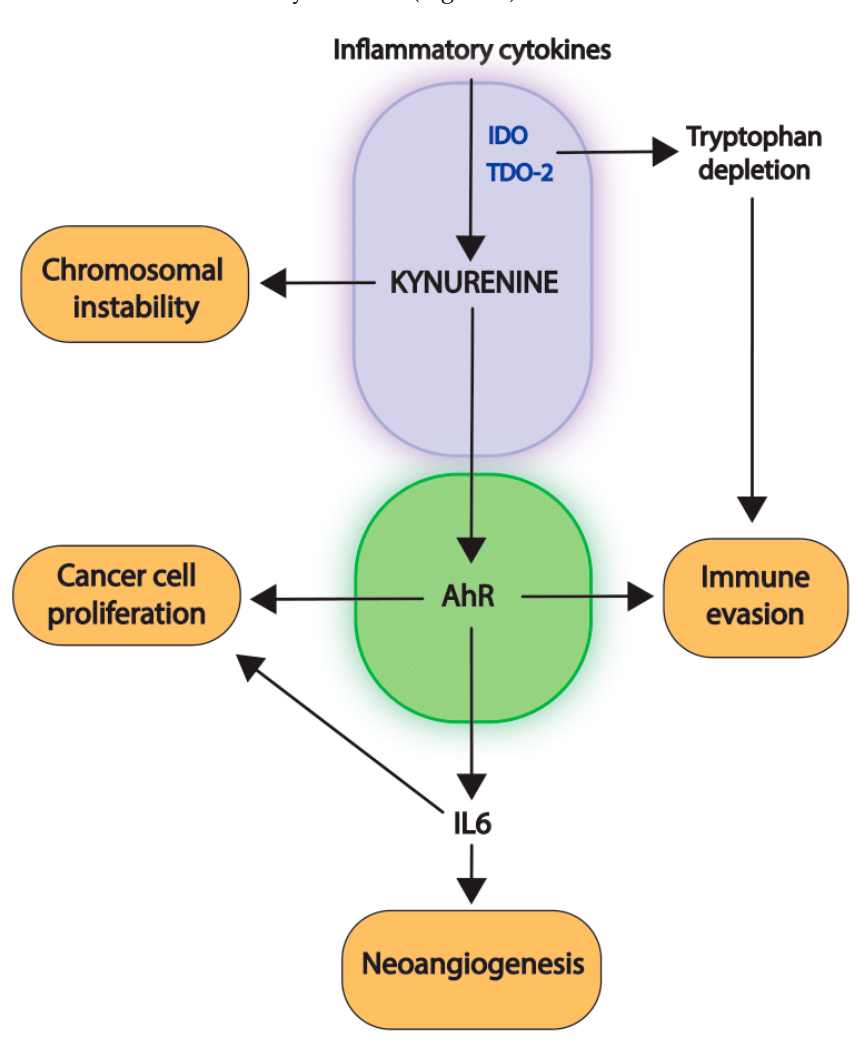
Figure 2. Pleiotropic kynurenine protumoral functions. Kynurenine production, resulting from IDO and/or TDO induction, leads to the AhR receptor activation to promote cancer cell proliferation, chromosomal instability, neoangiogenesis, immune evasion, metastatic dissemination and chemoresis- tance. AhR-independent functions of kynurenine also promote tumor growth. Tryptophan depletion, resulting from the kynurenine pathway activation, additionally contributes to the establishment of an immune tolerant